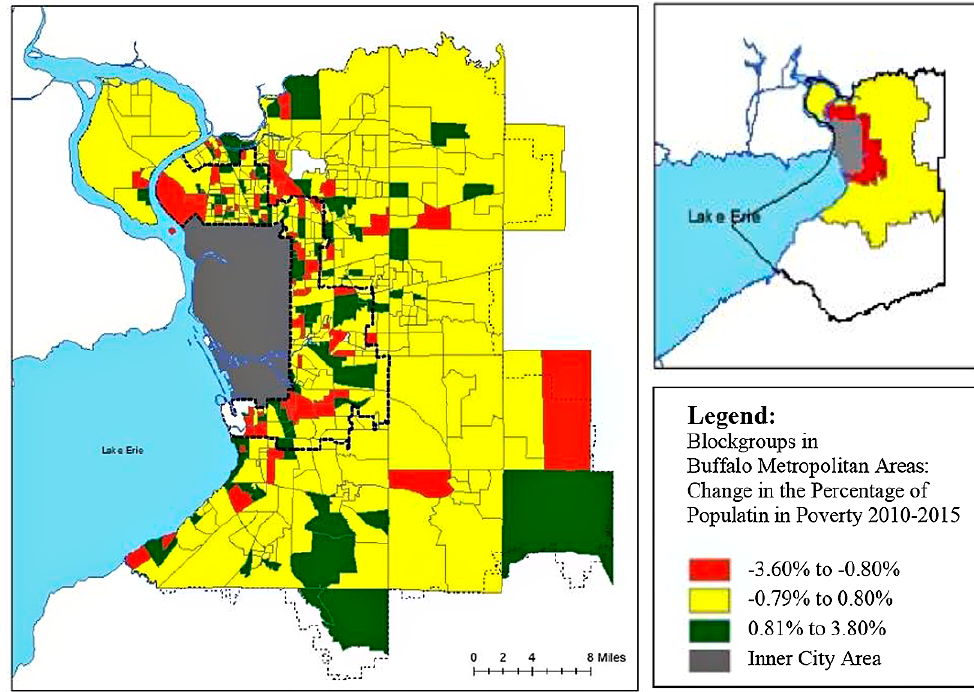
Figure 3. The second component contributing to Neighbourhood Change between 2010-2015 (The Percentage of Population in Poverty)